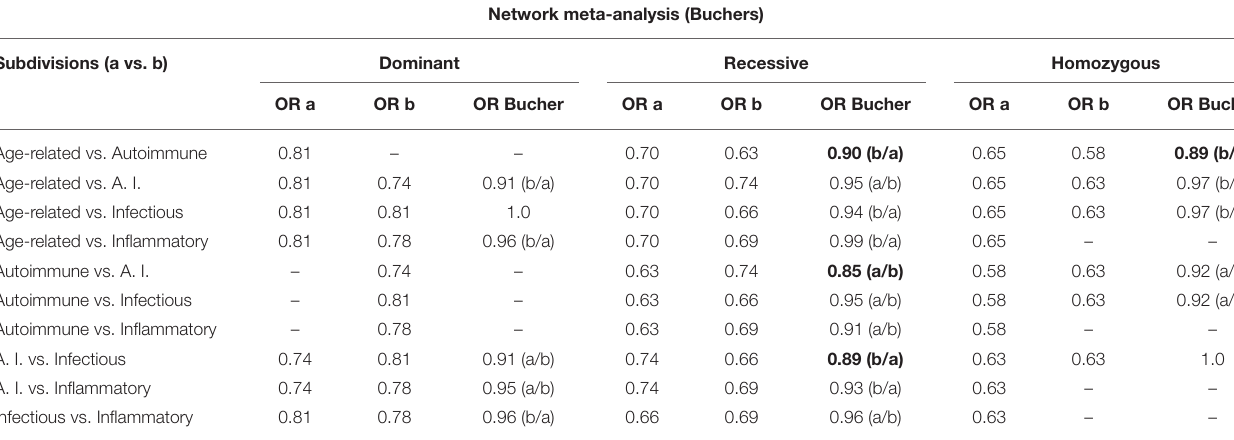
TABLE 4 | Network meta-analysis according to the method proposed by Bucher et al. (1997).